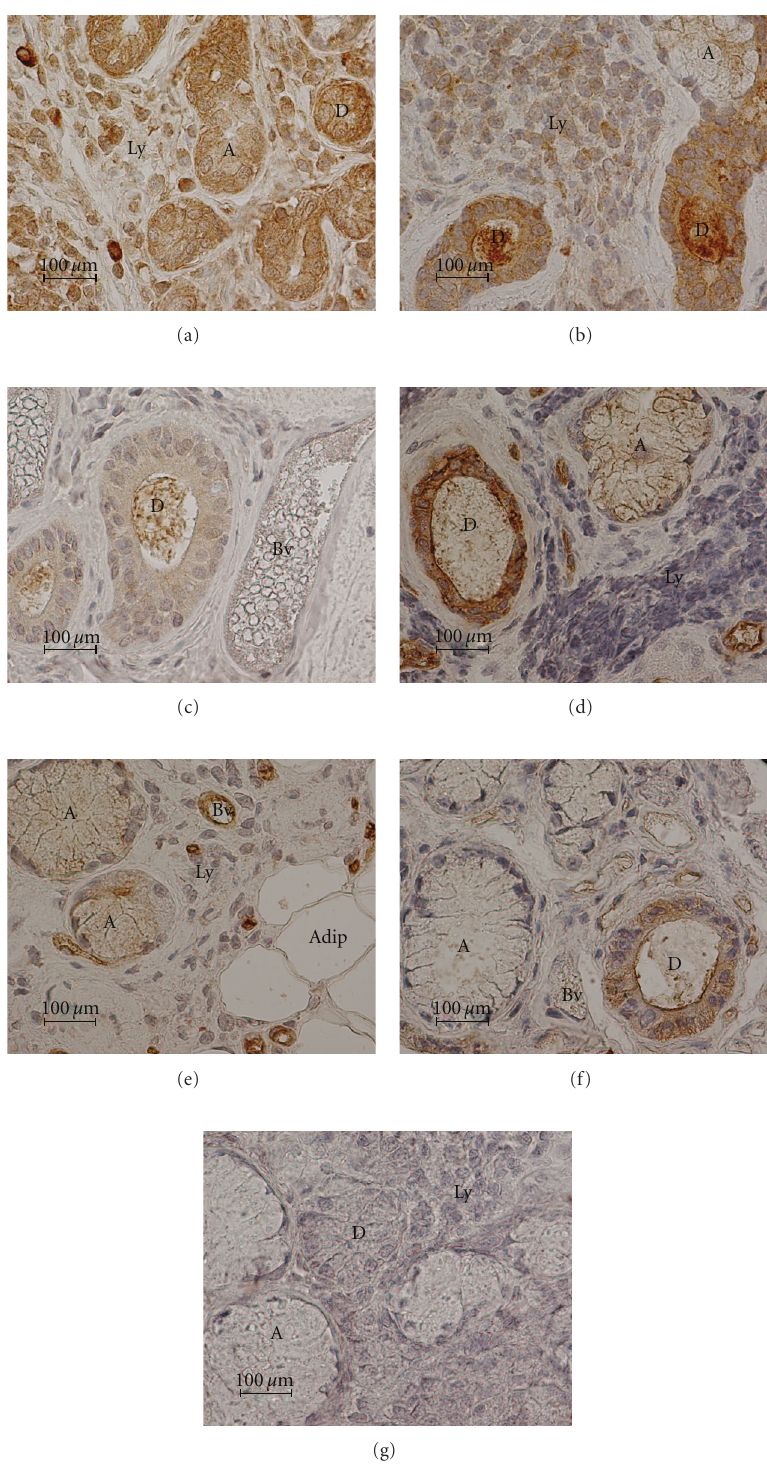
Figure 1: Expression of IL-17 and IL-17R in minor salivary glands of patients with pSS, probable preclinical pSS, and nonautoimmune sicca syndrome. IL-17: (a) pSS, (b) probable preclinical pSS, (c) nonautoimmune sicca syndrome. IL-17R: (d) pSS, (e) probable preclinical pSS, (f) nonautoimmune sicca syndrome, (g) negative staining control. Counterstained with hematoxylin. Original magnification × 400. Abbreviations: A: acinus, Adip-adipocytes, Bv: blood vessel, D: ductus, and Ly: lymphocyte